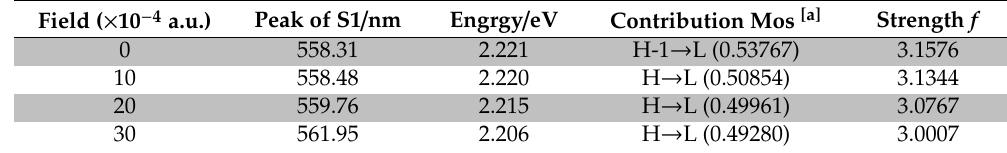
Table 7. Built-in electric field e ff ects on optical character of the PSC PB:IDT. Field ( × 10 − 4 a.u.) Peak of S1 / nm Engrgy / eV Contribution Mos